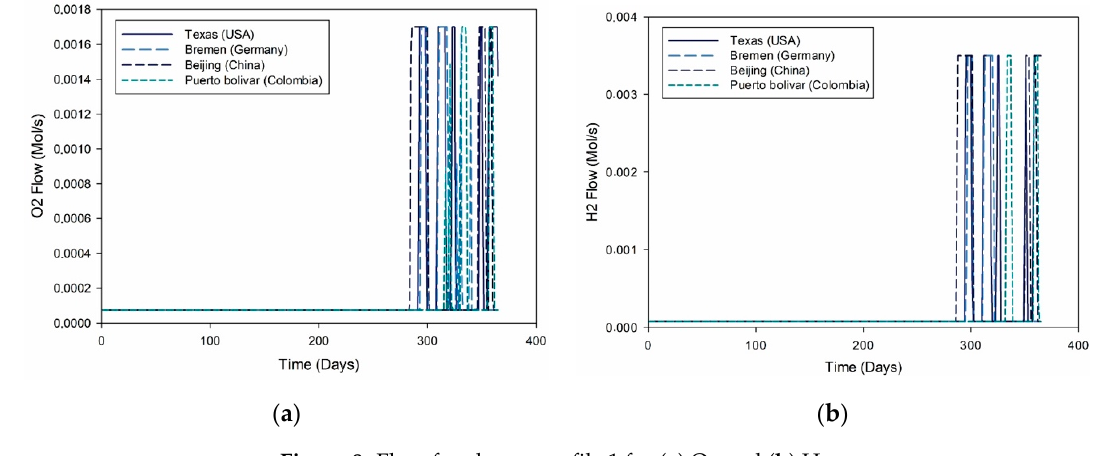
Figure 8. Flow for charge profile 1 for ( a ) O 2 and ( b ) H 2 .